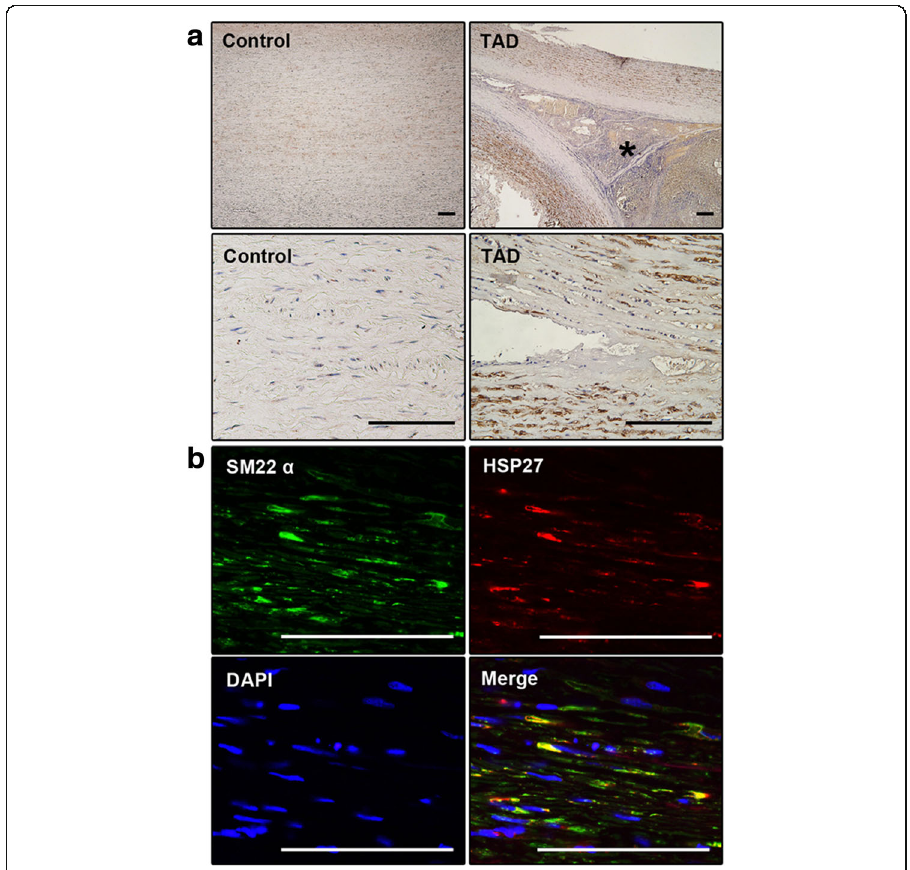
Fig. 2 Immunohistochemical analysis of HSP27 in the aortic samples of both controls and patients. a – HSP27 expression was higher in the aortic media of patients with TAD than in that of controls. HSP27-negative bands are observed along the tear in the aortic media of patients with TAD. * indicates false lumen. Scale bar = 100 μ m. b – Double immunofluorescence staining showing colocalization of HSP27 and SM22 α in the aortic media of TAD patients. Scale bar = 100 μ